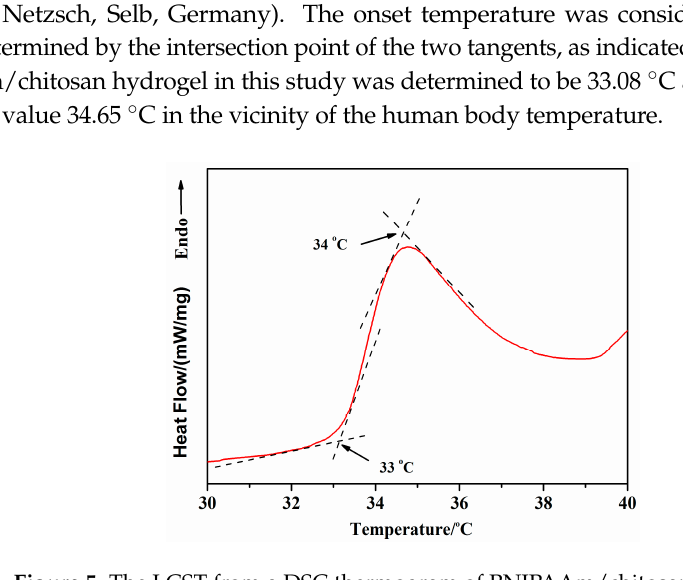
Figure 5. The LCST from a DSC thermogram of PNIPAAm/chitosan hydrogel.